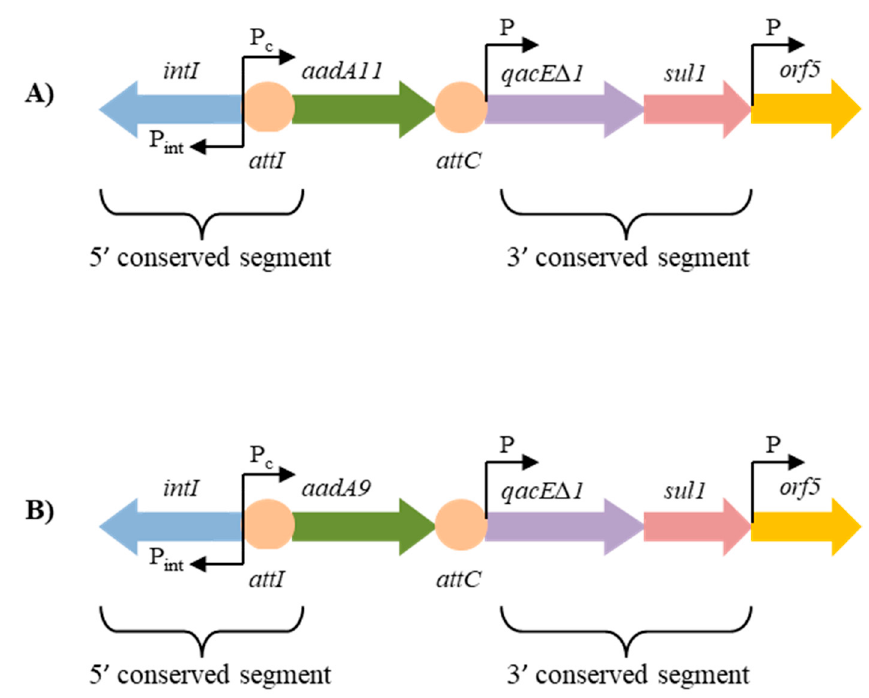
Figure 1. A schematic organization of the class 1 integrons and the aminoglycoside resistance gene cassettes aadA11 ( A ) and aadA9 ( B ) found in studied T. pyogenes isolates. Designations: intI , the